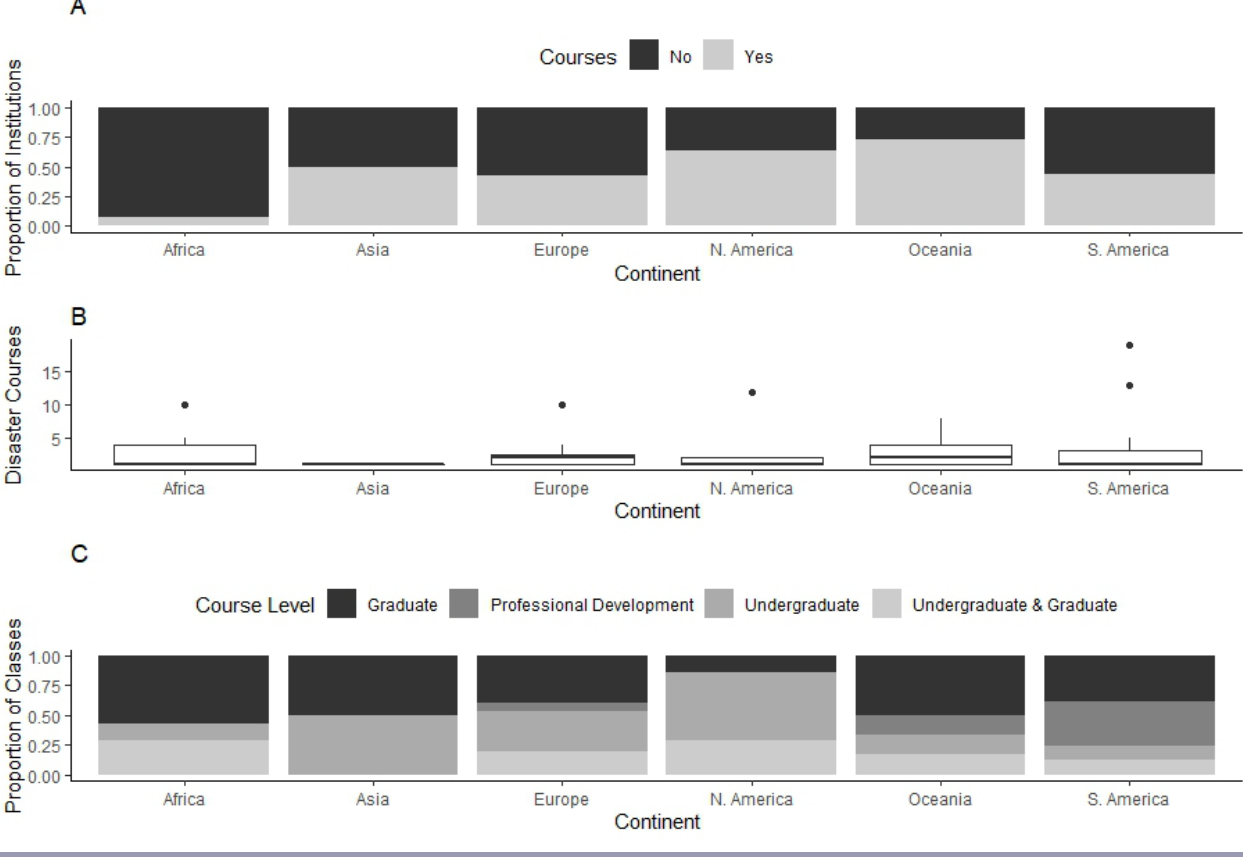
Fig. 3 . (A) The proportion of universities offering disaster-related course offerings, by continent (n = 120 universities of the top 500 universities worldwide); (B) The number of disaster-related courses offered per institution, by continent, where the middle horizontal line represents the median, bars represent the first and third quartiles, vertical lines represent the minimum and maximum range relative to the quartiles, and dots represent outliers; (C) The proportion of disaster-related courses taught according to education level, by